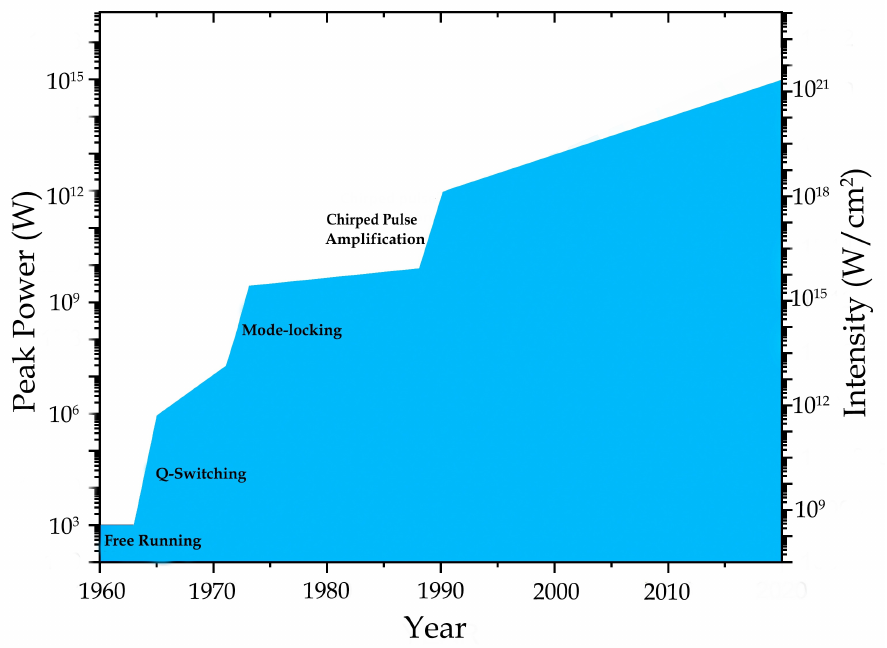
Figure 1. Pulsed laser peak power has increased over the past years as a result of introduction of succession of new techniques. The intensity available at the focal spot of the laser beam is presented on the right-Y